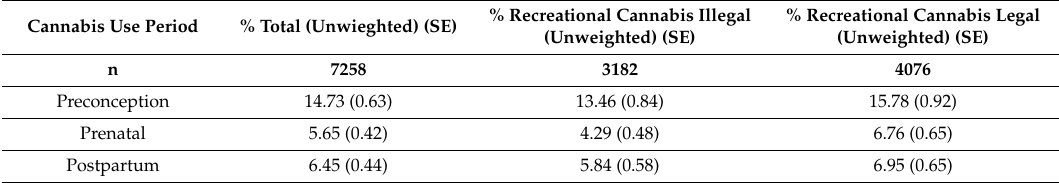
Table 2. Unadjusted cannabis use prevalence by cannabis law status in